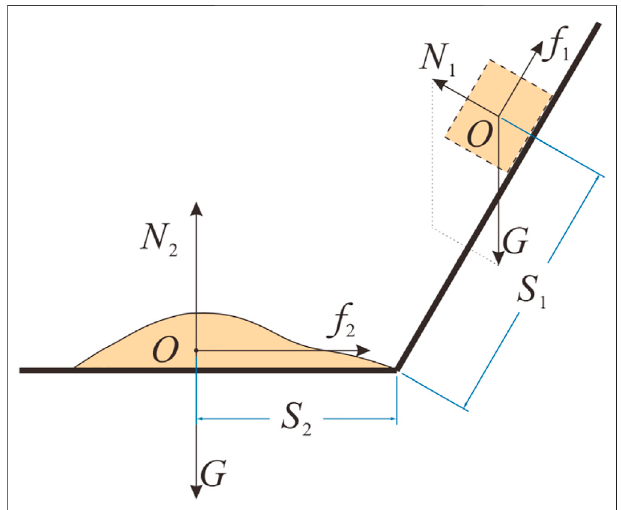
FIGURE 9 | Force analysis of the experimental